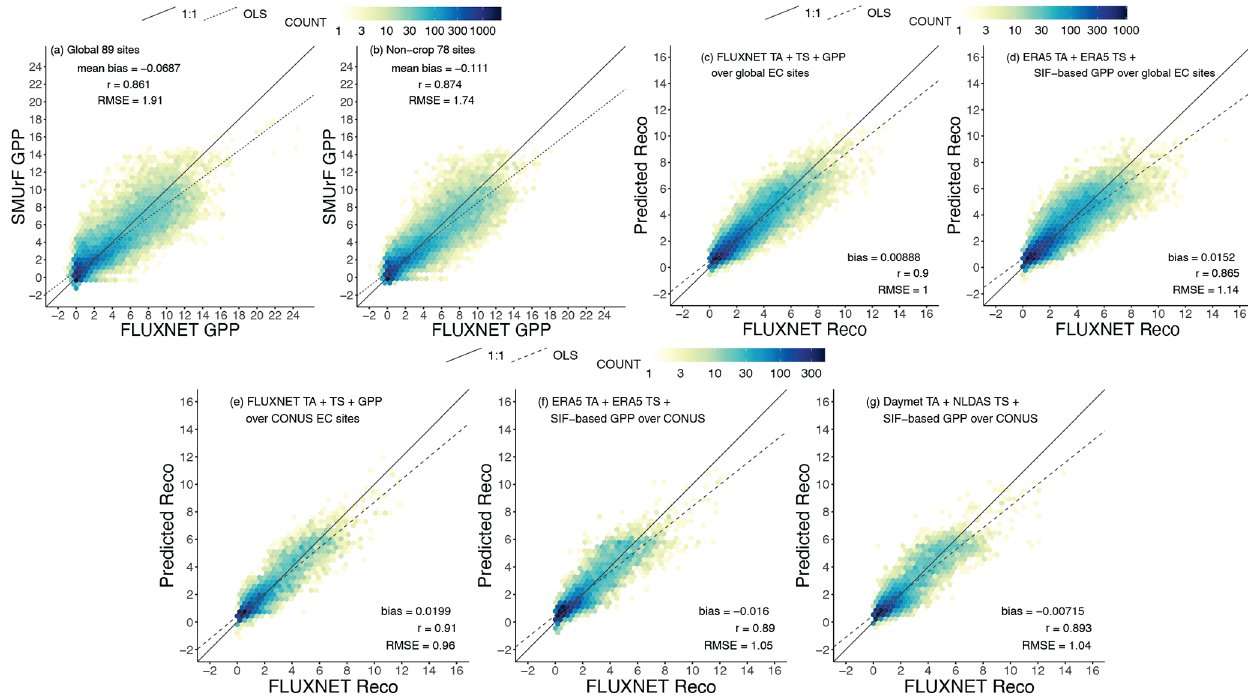
Figure 5. Comparisons between directly computed fluxes from SMUrF and observed fluxes from FLUXNET during 2010–2014 as density plots with 50 bins. All fluxes have units of µmolm − 2 s − 1 . (a–b) 4d mean observed GPP and directly computed SIF-based GPP at 89 global EC sites (a) and 78 non-crop sites (b) . (c–d) An evaluation of the daily mean observed R eco and predicted R eco in the testing set (i.e., 20% of all data) using observed T air + T soil + GPP from FLUXNET (c) or T air + T soil from ERA5 and SIF-based GPP (d) for 89 global EC sites. (e–g) Similar to panels (c) – (d) , but the model–data R eco comparison only for US EC sites and modeled R eco is calculated using Daymet T air , NLDAS T soil , and SIF-based GPP (g) . Although GPP and R eco were trained and predicted separately per biome, model–data pairs from all biomes are collected for visualization purposes. For each panel, numbers of data points in each of the 50 bins are displayed in log 10 scales as yellow–blue colors, and error statistics including the mean bias, correlation coefficient, and RMSE are printed. The 1 : 1 and ordinary- least-square-based (OLS-based) regression lines are displayed as solid and dashed lines. RMSEs derived from these direct validations were further used for assigning uncertainties at the 500m grid cell (Sect.